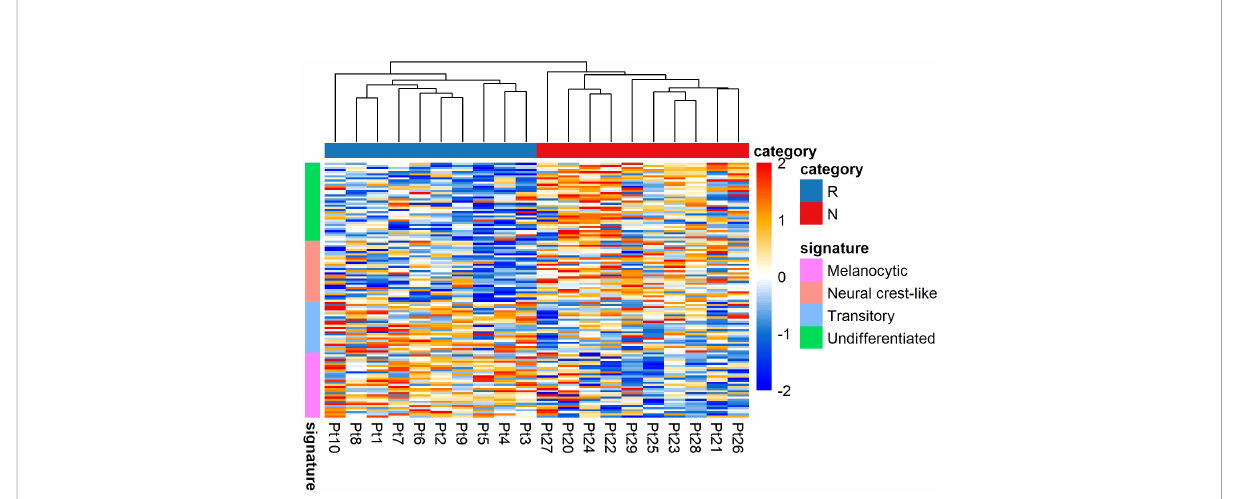
FIGURE 5 Transcriptomic states of responding (n = 10) versus non-responding (n = 10) melanomas. The non-responder group of melanomas exhibited undifferentiated and neural crest-like gene expression signatures. In contrast, the responder group of melanomas mainly exhibited melanocytic and transitory gene expression signatures. Values are in z-score. Here, Pt, patient; R, responder; N,